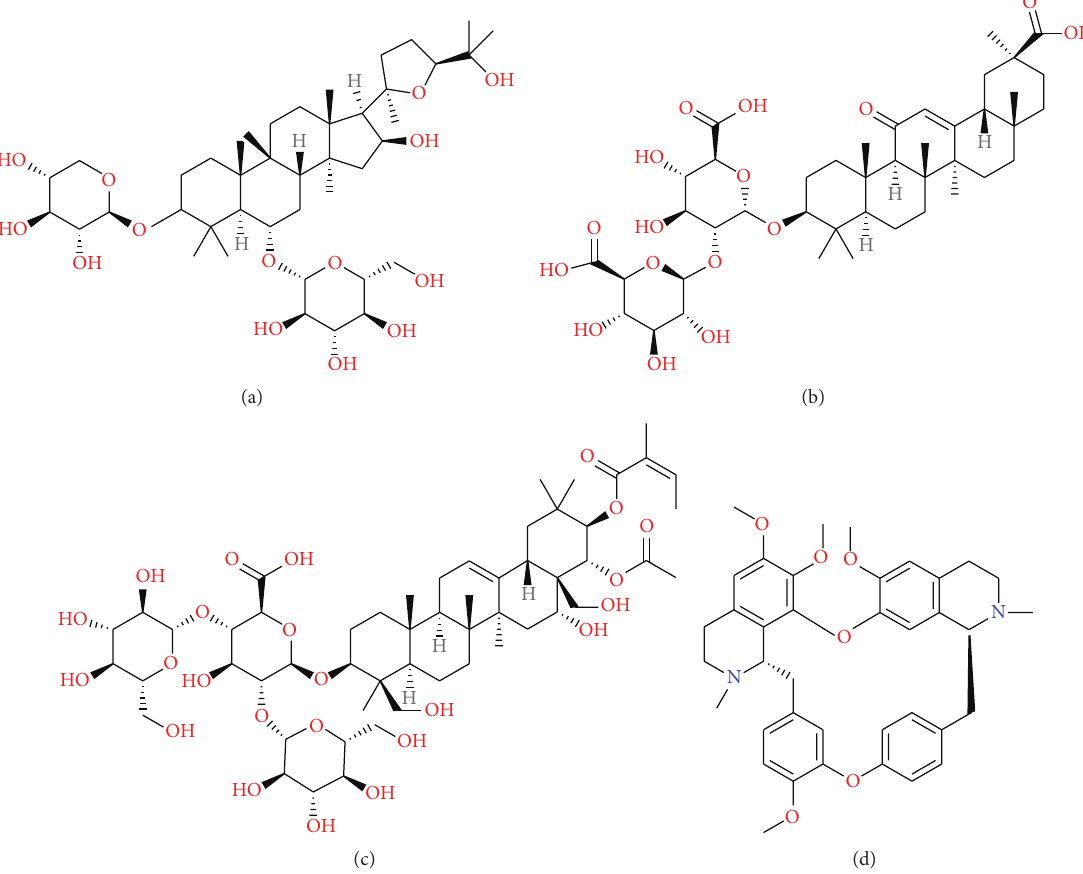
Figure 2: Structure of natural components: (a) Astragaloside IV, (b) Glycyrrhizin, (c) Beta-aescin, and (d) Tetrandrine.